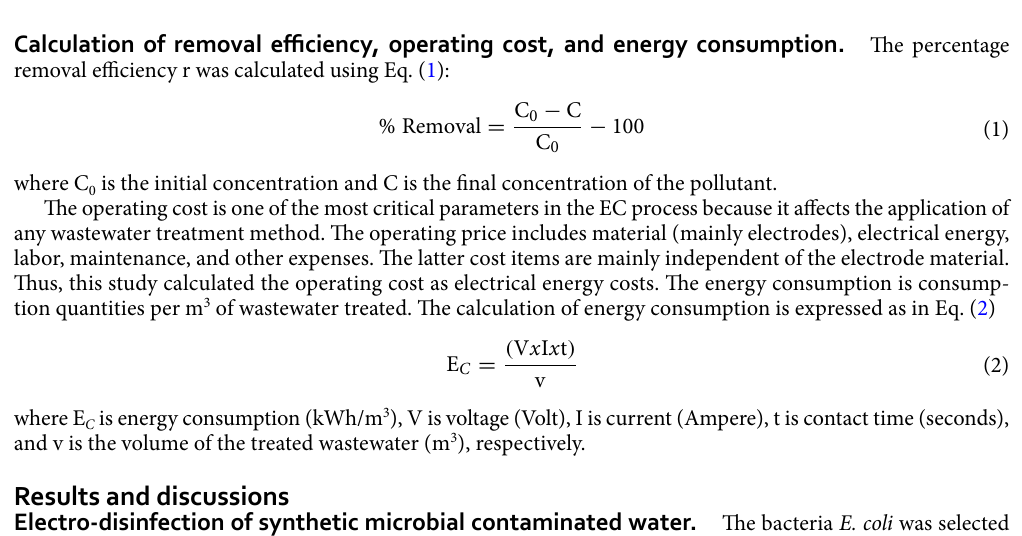
Figure 2. Effect of exposure time (1–15 min) on E. coli during electrochemical inactivation treatment. Experimental data are shown as mean ± standard deviation (n =